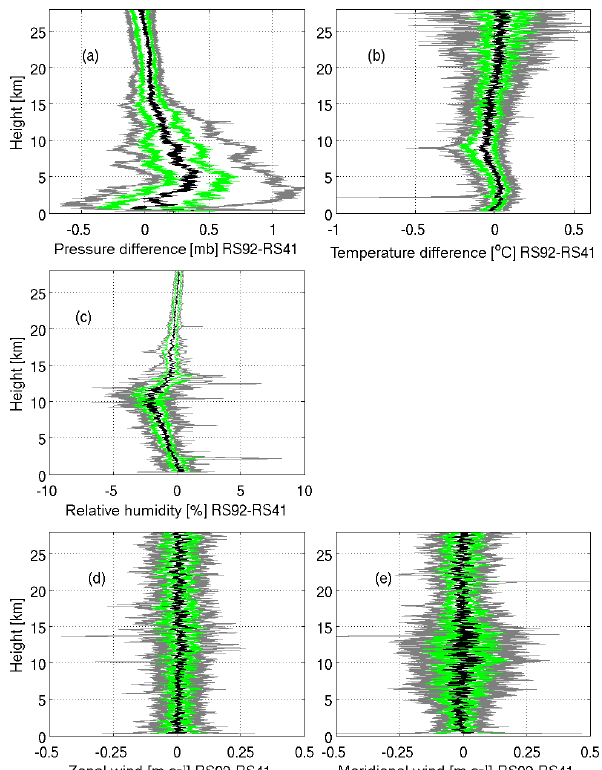
Figure 8. Vertical profiles of the median (black), 25–75th per- centile (green), and 10–90th percentile (grey) differences between RS92 and RS41 observations (RS92 − RS41) for (a) pressure, (b) dry-bulb temperature, (c) relative humidity, (d) zonal wind, and (e) meridional